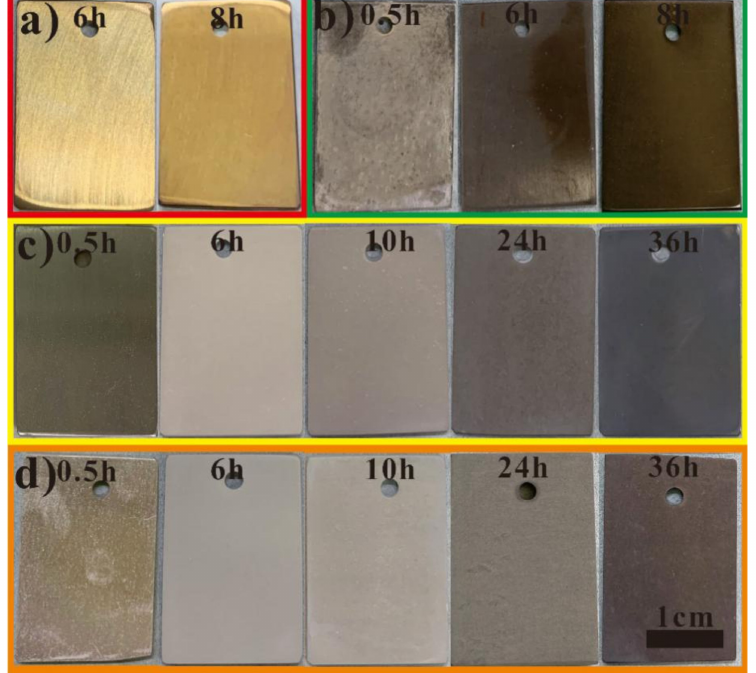
Figure 3. Digital images of ( a ) blank; ( b ) MBT; ( c ) Mg–Al LDHs; and ( d ) Mg–Al LDHs/MBT films synthetize with various reaction times at 95 ◦ C and 1 barometric pressure. Reprinted with permission from [26]; Copyright 2021